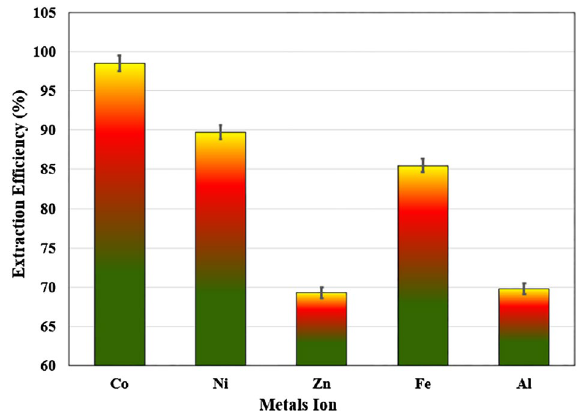
Figure 12. Extraction of other heavy metal ions with PEG1000-ammonium sulfate